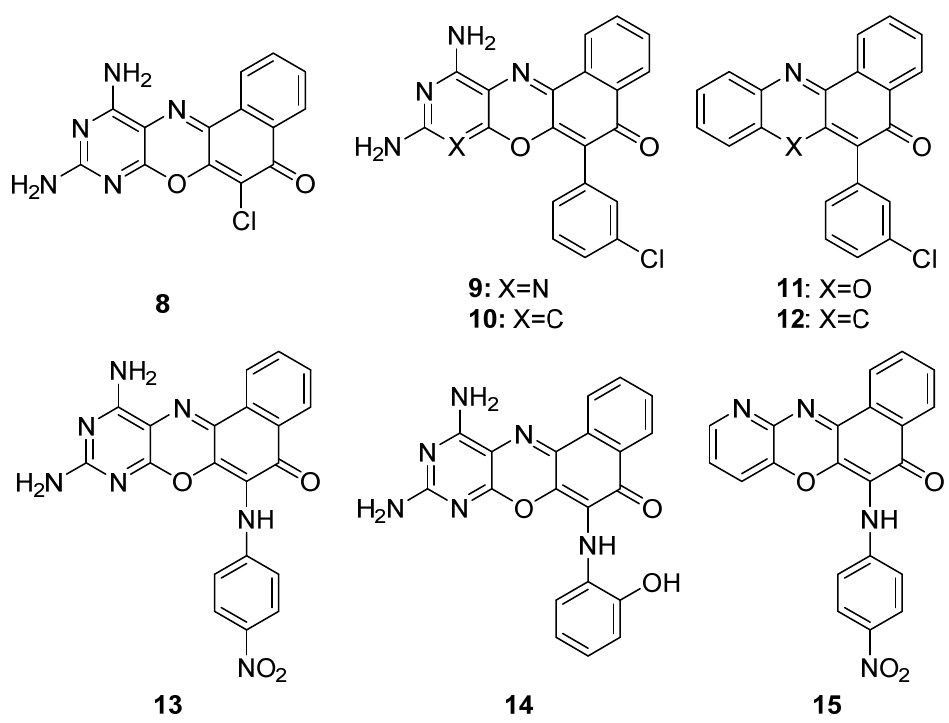
Figure 11. Compound 8 and derivatives obtained by arylation using boronic acids ( 9 – 12 ) or by amination using anilines ( 13 – 15 ).